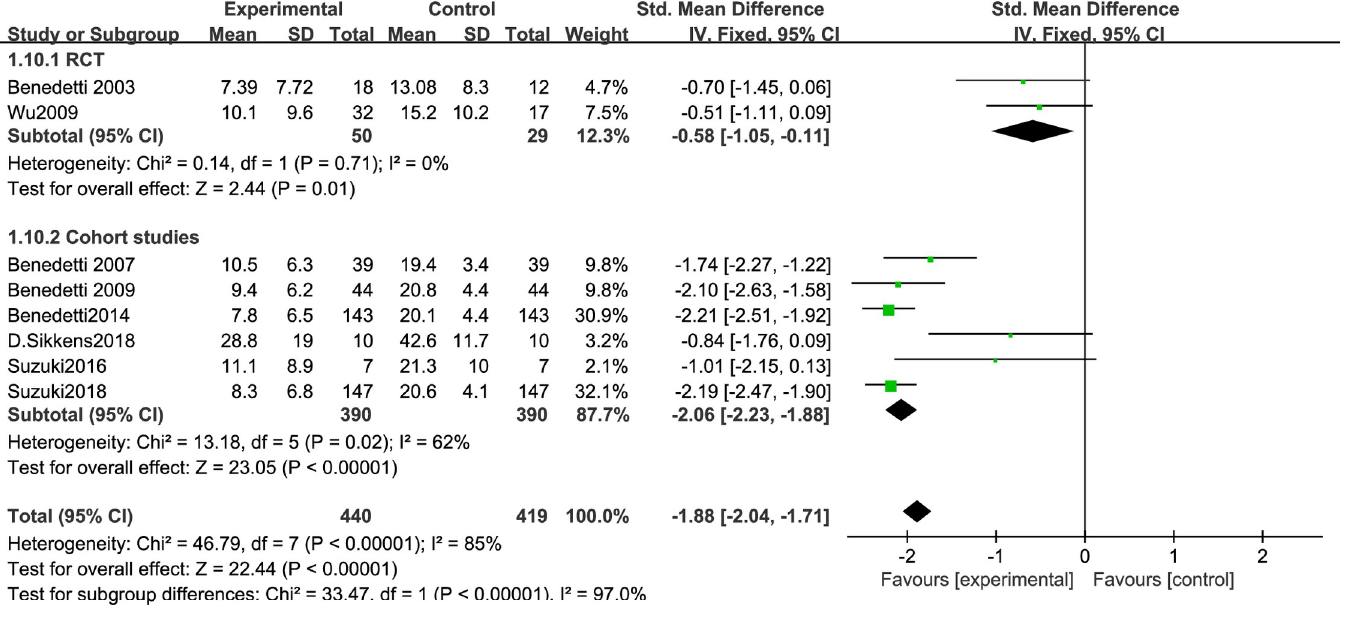
Fig 4. Forest plots with phototherapy less than 10h.